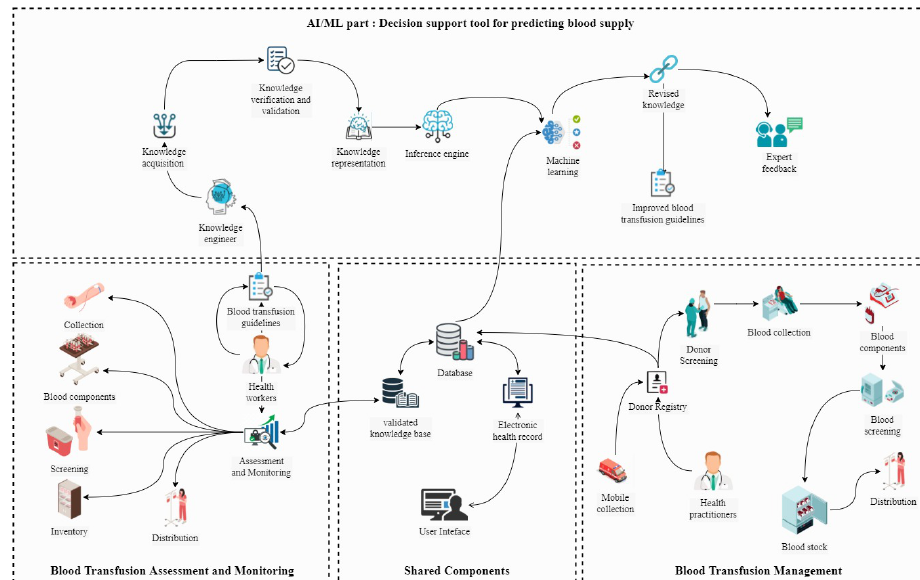
Figure 3. System architecture.